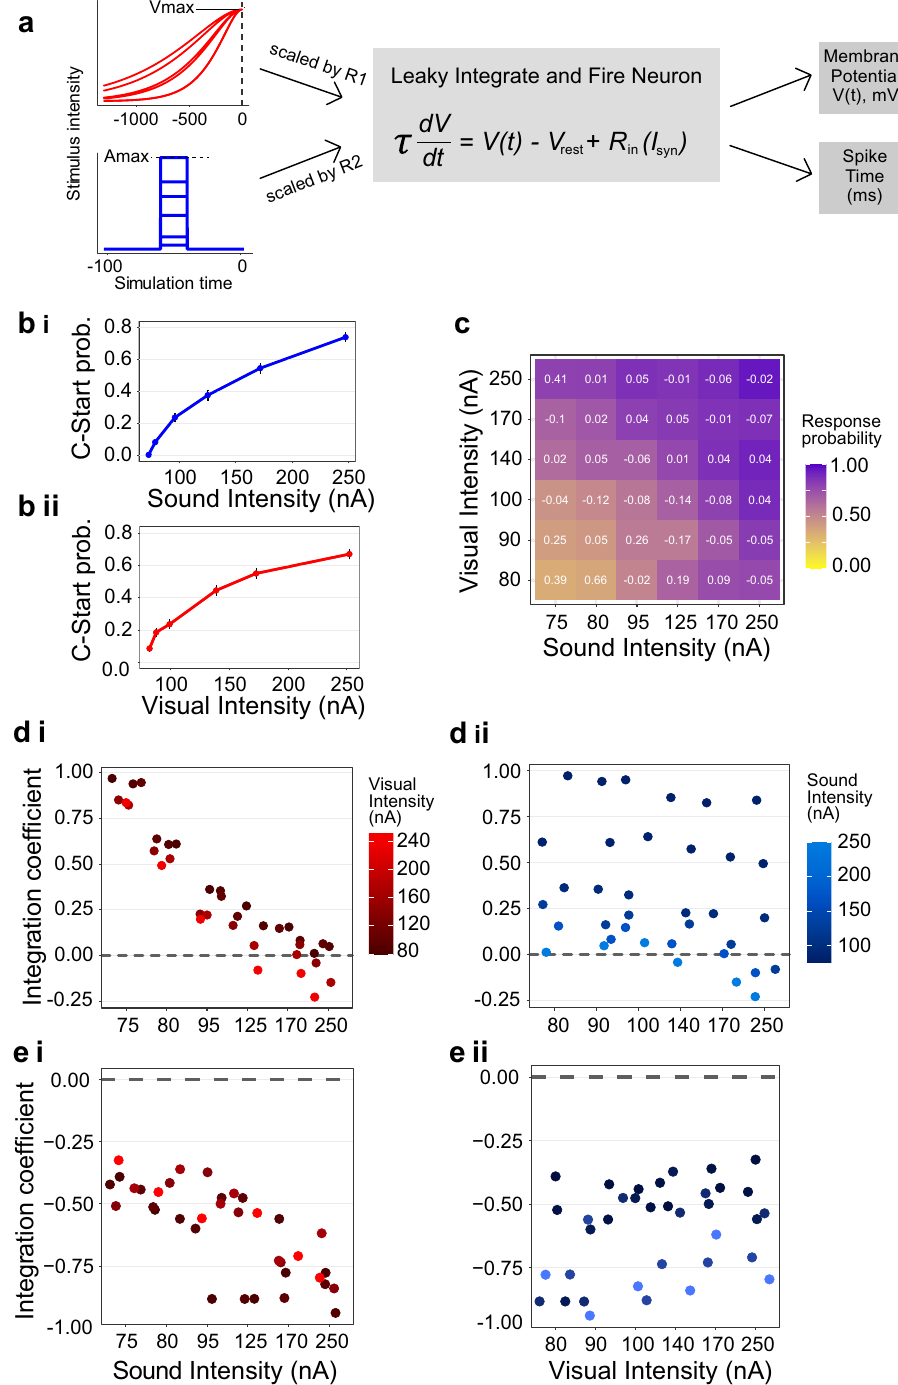
Figure 5. An integrate-and-fire neuron model explains multisensory enhancement of C-start behavior. ( a ) Model Diagram. Functions representing visual (upper left) or auditory (lower left) input converge onto the Mauthner cell model (central panel). Output variables measured are membrane potential and spike time when threshold is reached. ( b ) Response probability as a function of stimulus intensity for unisensory trials. Six auditory ( b i ) or visual ( b ii ) intensities were fitted so that response probability matched behavioral results for non-freezing animals (n = 1200). ( c ) C-start probability for multisensory trials. Numbers in white represent the relative difference with the experimental response probability, calculated as (p(mod) − p(exp))/(p(mod) + p(exp)) (cf., Fig. 4a). (d) ICs as a function of sound intensity and colored by visual intensity ( d i ) or as function of visual intensity and colored by auditory intensity ( d ii ). As in behavioral experiments, the model shows enhanced multisensory integration during the MSI period and inverse effectiveness for auditory intensity, although not for visual intensity. ( e ) Modelled ICs during the UV period as a function of sound intensity and colored by visual intensity ( e i ) or as a function of visual intensity colored by auditory intensity ( e ii ) (horizontal jitter applied to ease visualization). The dashed horizontal line represents no